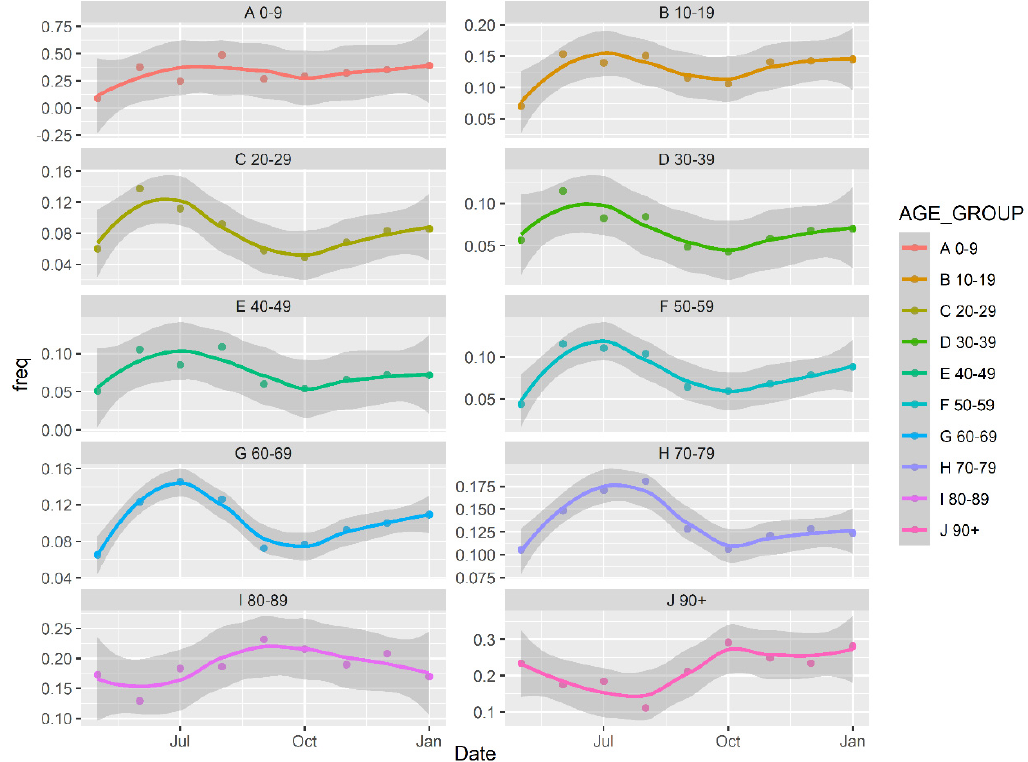
Figure 2. Frequency of asymptomatic cases per age group.